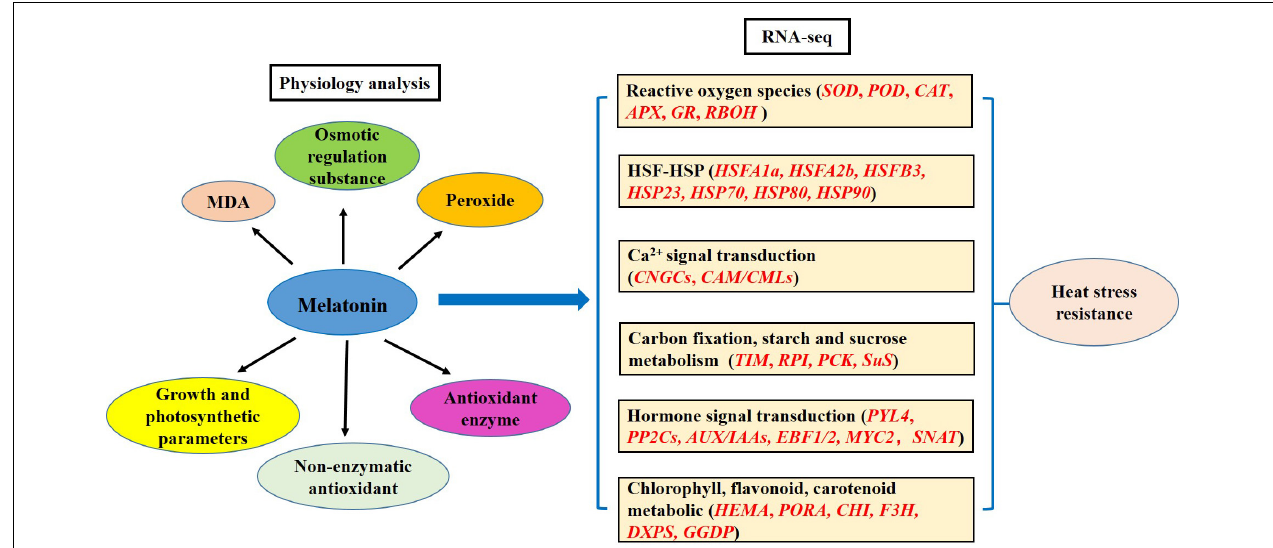
FIGURE 9 | Model of melatonin regulating the adaptability of chrysanthemum seedlings to heat